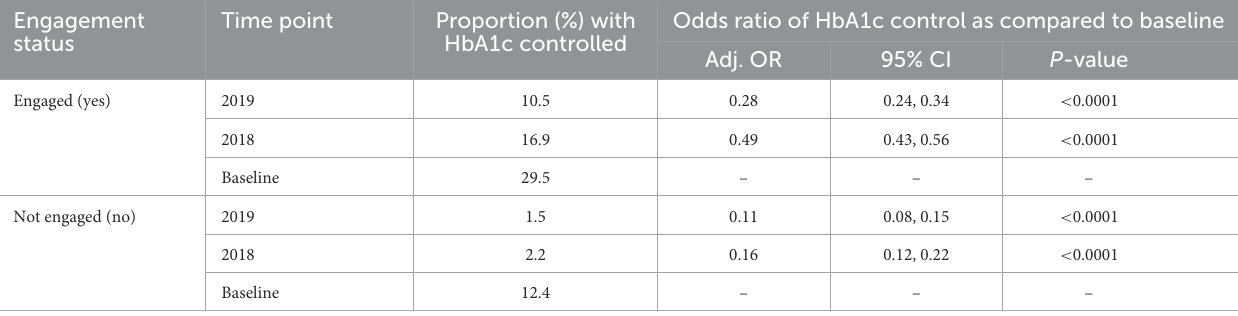
TABLE 4 Mean comparisons of measurement period by SUD treatment engagement status 2016–2019 among HCN patients with type 2 diabetes and SUD. Engagement